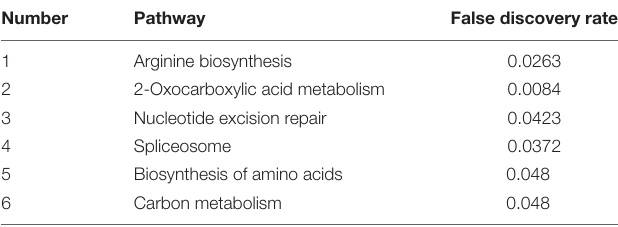
TABLE 3 | Pathway classification of differentially expressed genes (DEGs).